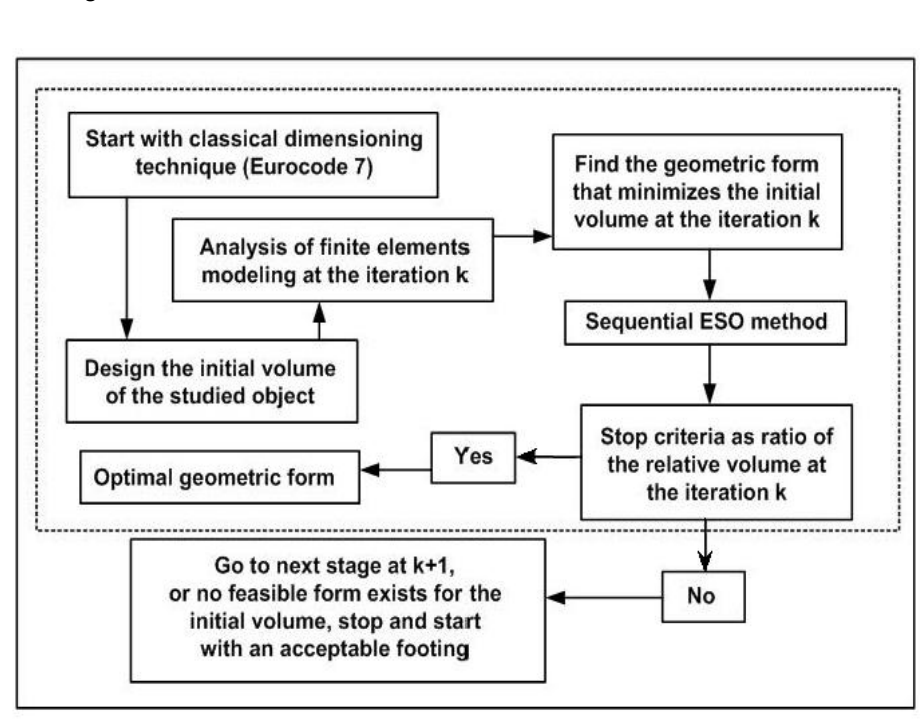
Figure 4. Flowchart of optimal forms